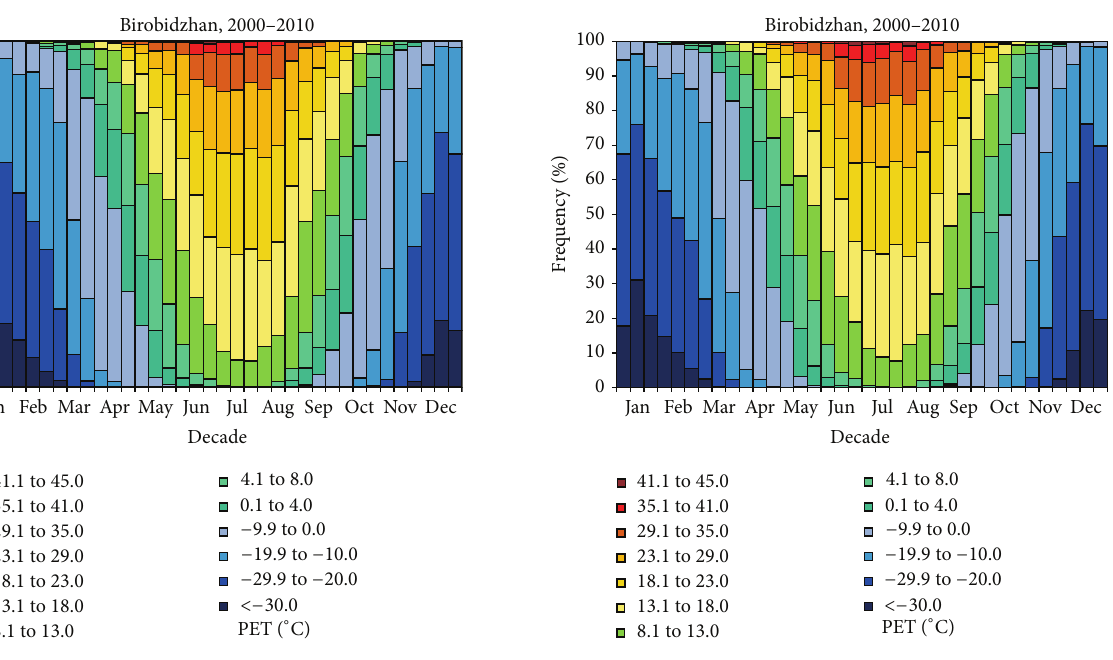
times marked the end of spring and the beginning of autumn.